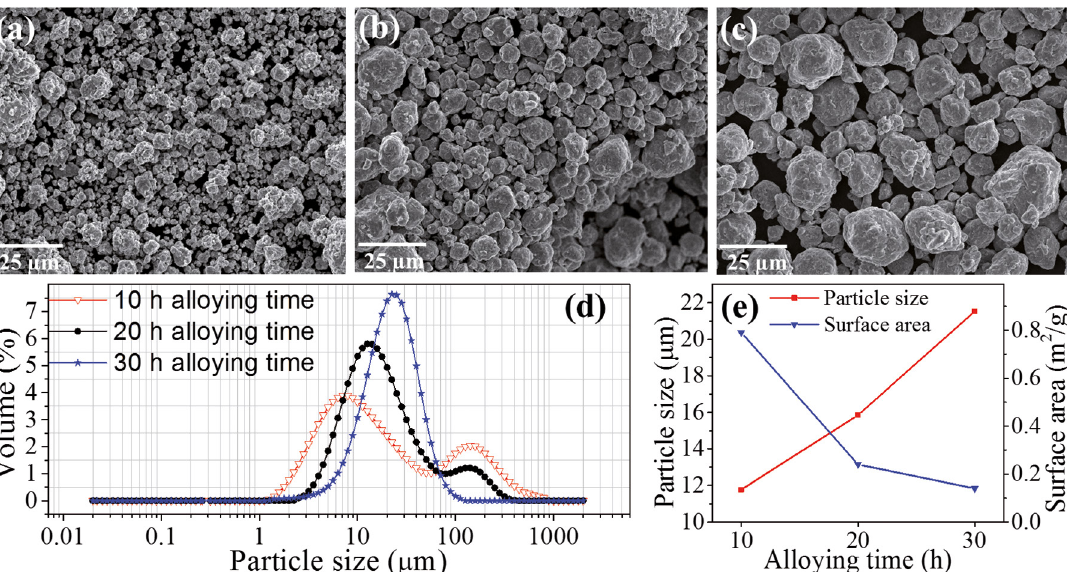
Figure 2: SEM micrographs of MA’ed AlCoNi powder alloy after (a) 10 h, (b) 20 h and (c) 30 h of milling, (d) particle size distribution curves and (e) mean particle size and surface area.